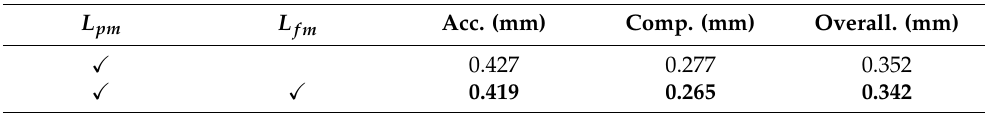
Table 4. Ablation study on feature-metric loss in the teacher model. L pm and L fm denote photometric loss and feature-metric loss